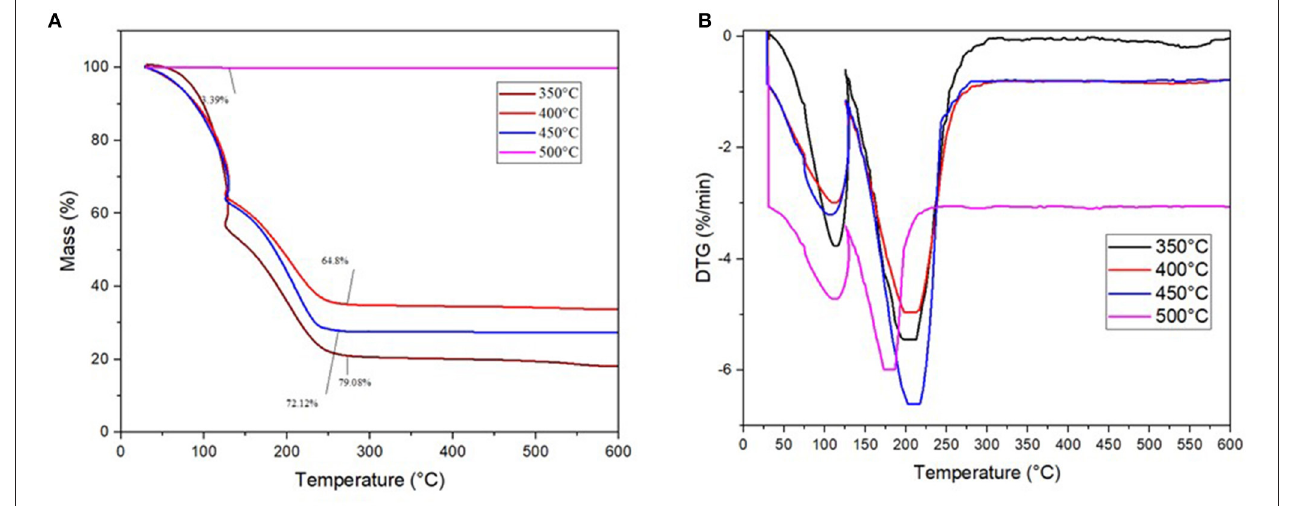
FIGURE 10 | (A) Mass loss profile of pyrolysis oil. (B) DTG curve of pyrolysis oil.